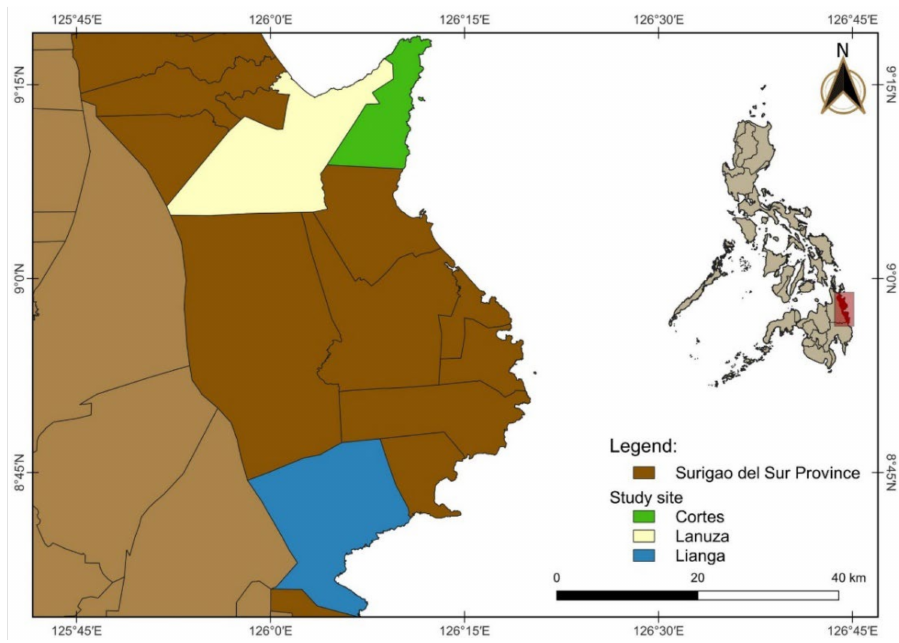
Figure 1. Location map showing the three municipalities of the study